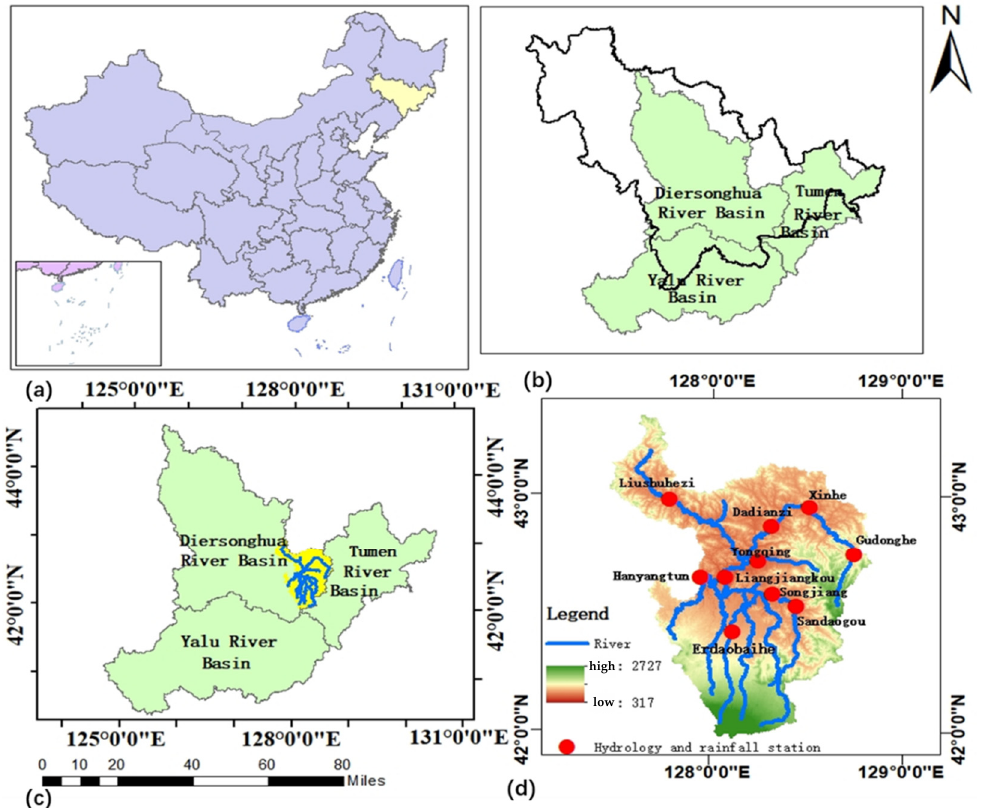
Figure 1. Study area. ( a ) Map of China. ( b ) The Yalu River, the Tumen River, and the Second Songhua River originate from Changbai Mountain, of which the Second Songhua River is located in Jilin Province. ( c ) The location of the study area. ( d ) Elevation map of the study area, as well as a schematic diagram of the site and water system.